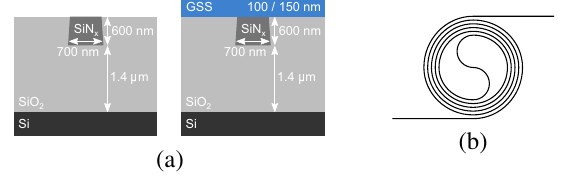
Figure 2. Cross section of studied waveguides (a). Example of a spiral shaped waveguide used for characterisation (b).